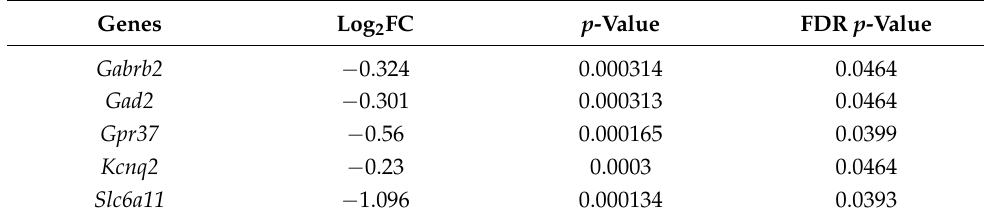
Table 5. GABA receptor signaling genes in Homo PKC γ